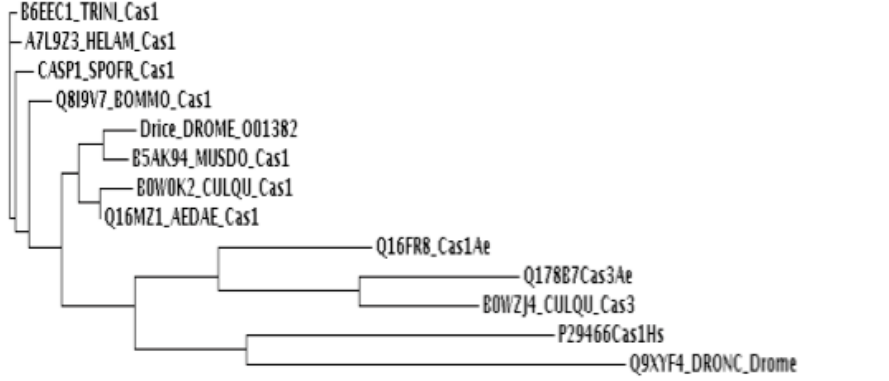
Figure 3. Phylogenetic tree of Cas-1 proteins from different insects and from humans. A phylogenetic tree was constructed using the following sequences: Cas-1 from Bombyx mori (Q8I9V7), Spodoptera frugiperda (P89116), Trichoplusia ni (B6EEC1) Helicoverpa armigera (A7L9Z3), Drosophila melanogaster (O01382), D. melanogaster (Q9XYF4), Culex quinquefasciatus (B0W0K2), Musca domestica (B5AK94), Aedes aegypti (Q16MZ1), A. aegypti (Q16FR8), Homo sapiens (P29466) and Cas-3 from A. aegypti (Q178B6) and C. quinquefasciatus (B0WZJ4).